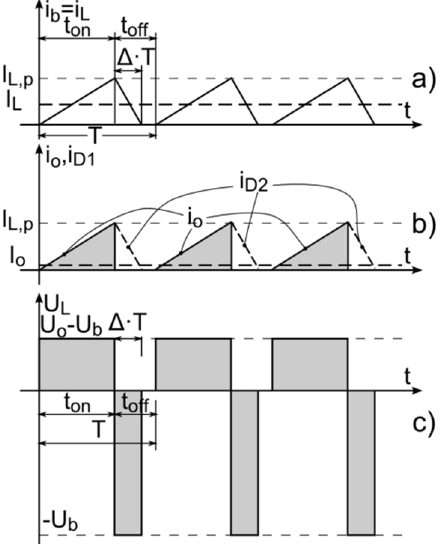
Figure 11. Layout 1 charge operation: current and voltage waveforms (discontinuous